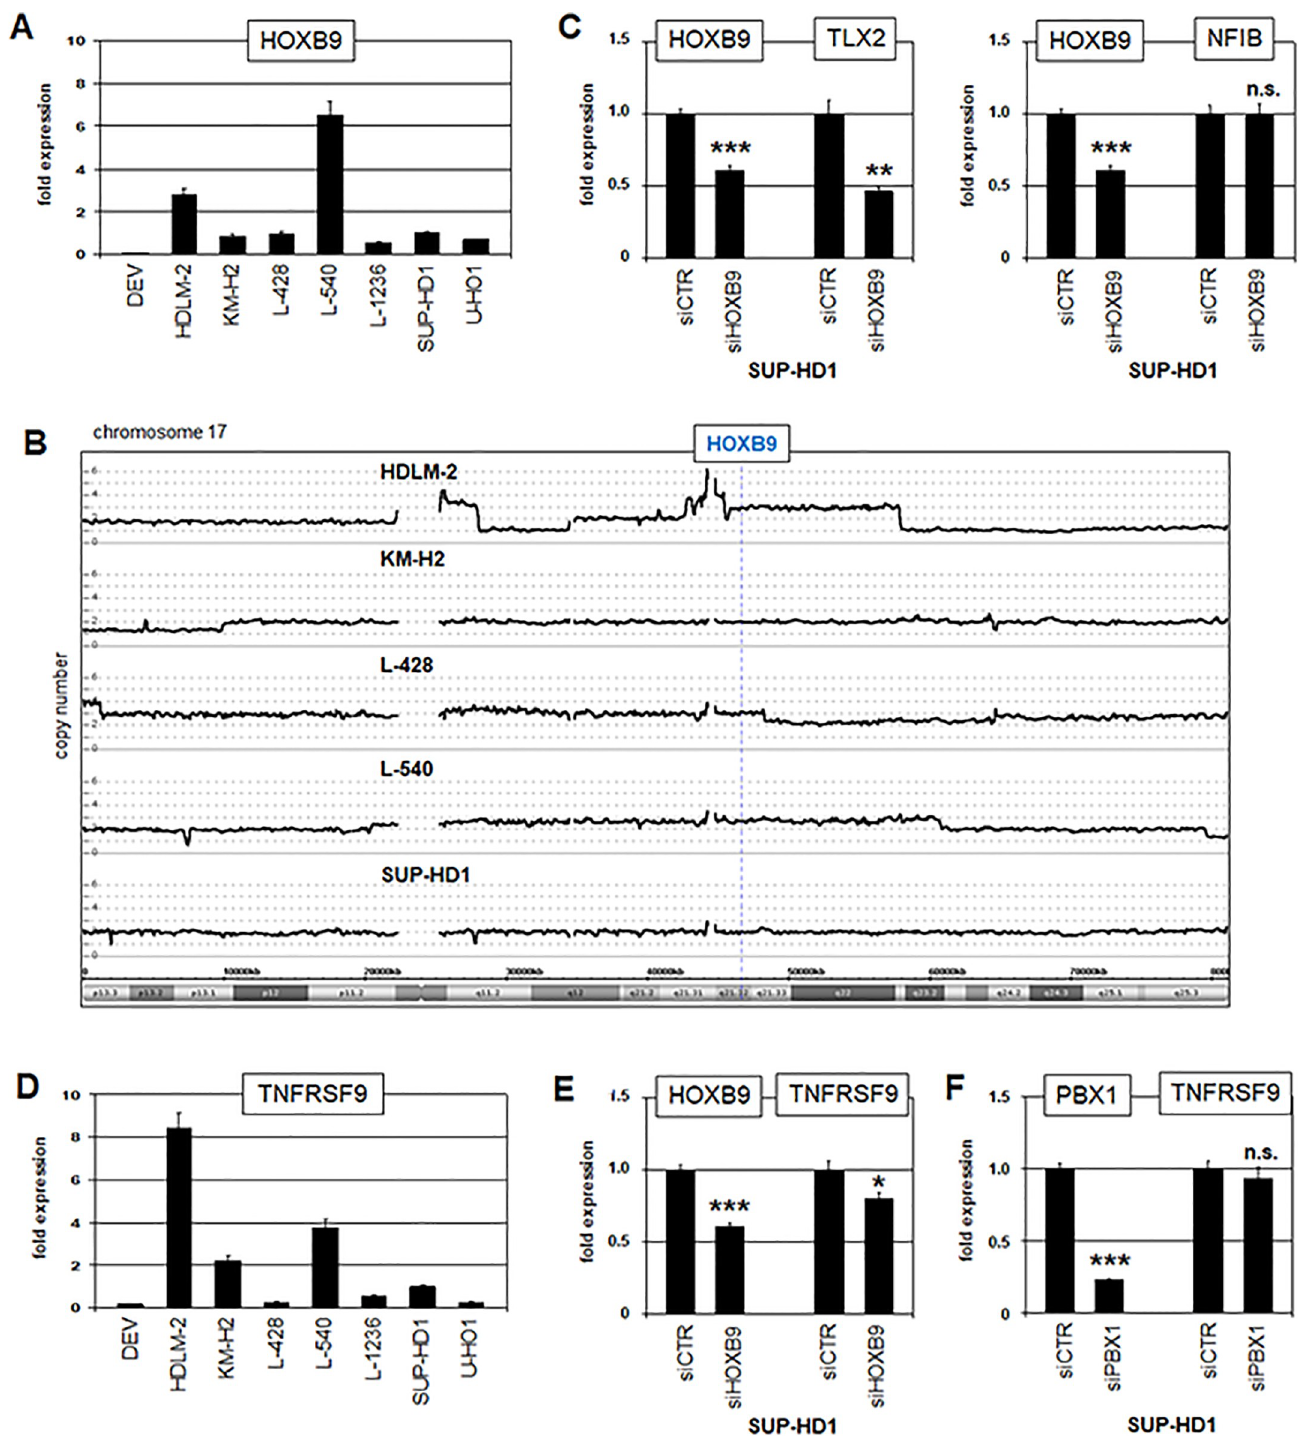
Fig 6. Cooperation of PBX1 and HOXB9. (A) RQ-PCR analysis of HOXB9 in HL cell lines, demonstrating enhanced transcript levels in HDLM-2 and L-540. (B) Genomic profiling data of HL cell lines HDLM-2, KM-H2, L-428, L-540 and SUP-HD1, showing copy number states for HOXB9 at chromosomal position 17q21. (C) RQ-PCR analyses of HOXB9 and TLX2 (left) and of HOXB9 and NFIB (right) in HL cell line SUP-HD1 treated for siRNA-mediated knockdown of HOXB9. The results indicated that HOXB9 activated TLX2 but not NFIB. (D) RQ-PCR analysis of TNFRSF9 in HL cell lines, demonstrating enhanced transcript levels in HDLM-2 and L-540. Please note the correlation of TNFRSF9 and HOXB9 expressio levels. (E) RQ-PCR analyses of HOXB9 and TNFRSF9 in HL cell line SUP-HD1 treated for siRNA-mediated knockdown of HOXB9, indicating that HOXB9 activated TNFRSF9 expression. (F) RQ-PCR analyses of PBX1 and TNFRSF9 in HL cell line SUP-HD1 treated for siRNA-mediated knockdown of PBX1, indicating that PBX1 did not regulate TNFRSF9 expression. https://doi.org/10.1371/journal.pone.0246603.g006 PLOS ONE | https://doi.org/10.1371/journal.pone.0246603 February 4,